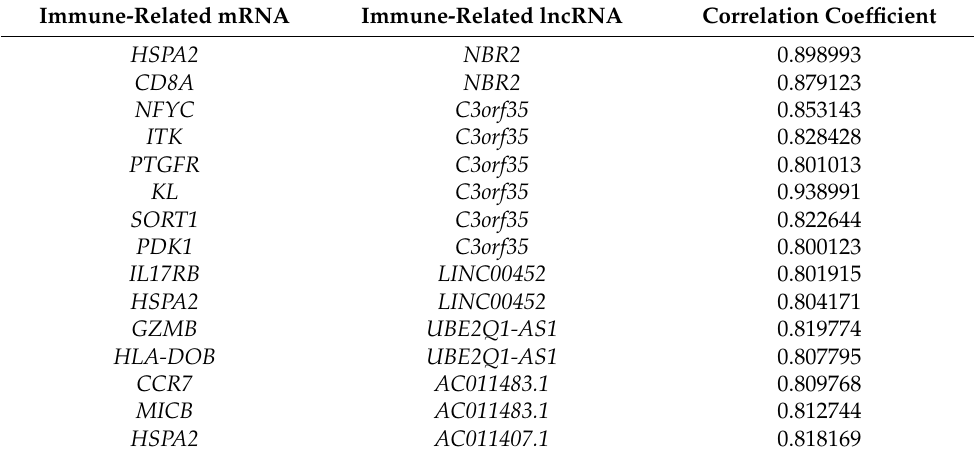
Table 2. The lncRNA–mRNA pairs included in the ceRNA